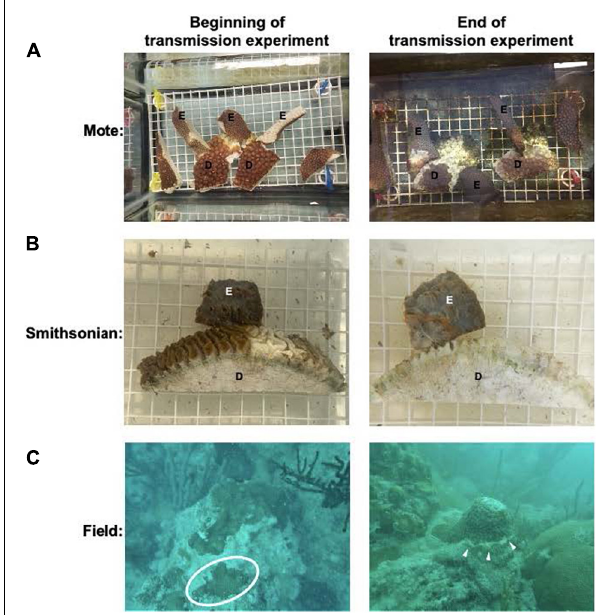
FIGURE 1 | Example of the disease transmission experimental set up. In both (A,B) E: experimental fragments, D: diseased coral used to transmit the SCTLD. (A) Represents an example of the set up for the transmission assay at Mote Marine Laboratory. (B) Represents an example set up for the transmission assay at the Smithsonian Marine Station. (C) An apparently healthy O. faveolata colony collected from the Airport Coral Heads site in Key West in July 2019, which at the time, was ahead of the known SCTLD endemic region. Healthy coral is found within the circle. Right panel shows a M. cavernosa colony affected with SCTLD, exhibiting one subacute tissue loss lesion as indicated by the white arrows. These were collected from Looe Key for the Mote transmission experiment in July